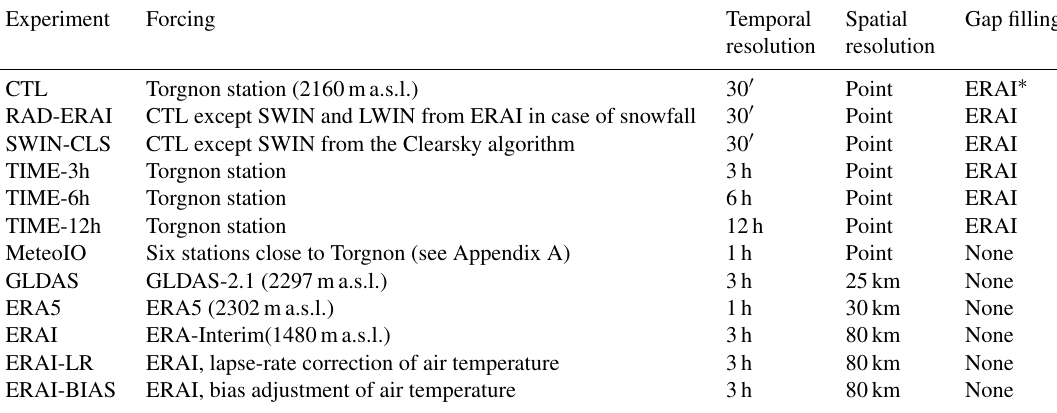
Table 2. Overview of the experiments and their characteristics in terms of forcing data, temporal and spatial resolutions and gap-filling data employed where necessary. For reanalysis datasets, the elevation of the grid point closest to the Torgnon station is reported. Experiment Forcing Temporal Spatial Gap filling resolution resolution CTL Torgnon station (2160ma.s.l.) 30 (cid:48) Point ERAI ∗ RAD-ERAI CTL except SWIN and LWIN from ERAI in case of snowfall 30 (cid:48) Point ERAI SWIN-CLS CTL except SWIN from the Clearsky algorithm 30 (cid:48) Point ERAI TIME-3h Torgnon station 3h Point ERAI TIME-6h Torgnon station 6h Point ERAI TIME-12h Torgnon station 12h Point ERAI MeteoIO Six stations close to Torgnon (see Appendix A) 1h Point None GLDAS GLDAS-2.1 (2297ma.s.l.) 3h 25km None ERA5 ERA5 (2302ma.s.l.) 1h 30km None ERAI ERA-Interim(1480ma.s.l.) 3h 80km None ERAI-LR ERAI, lapse-rate correction of air temperature 3h 80km None ERAI-BIAS 3h 80km